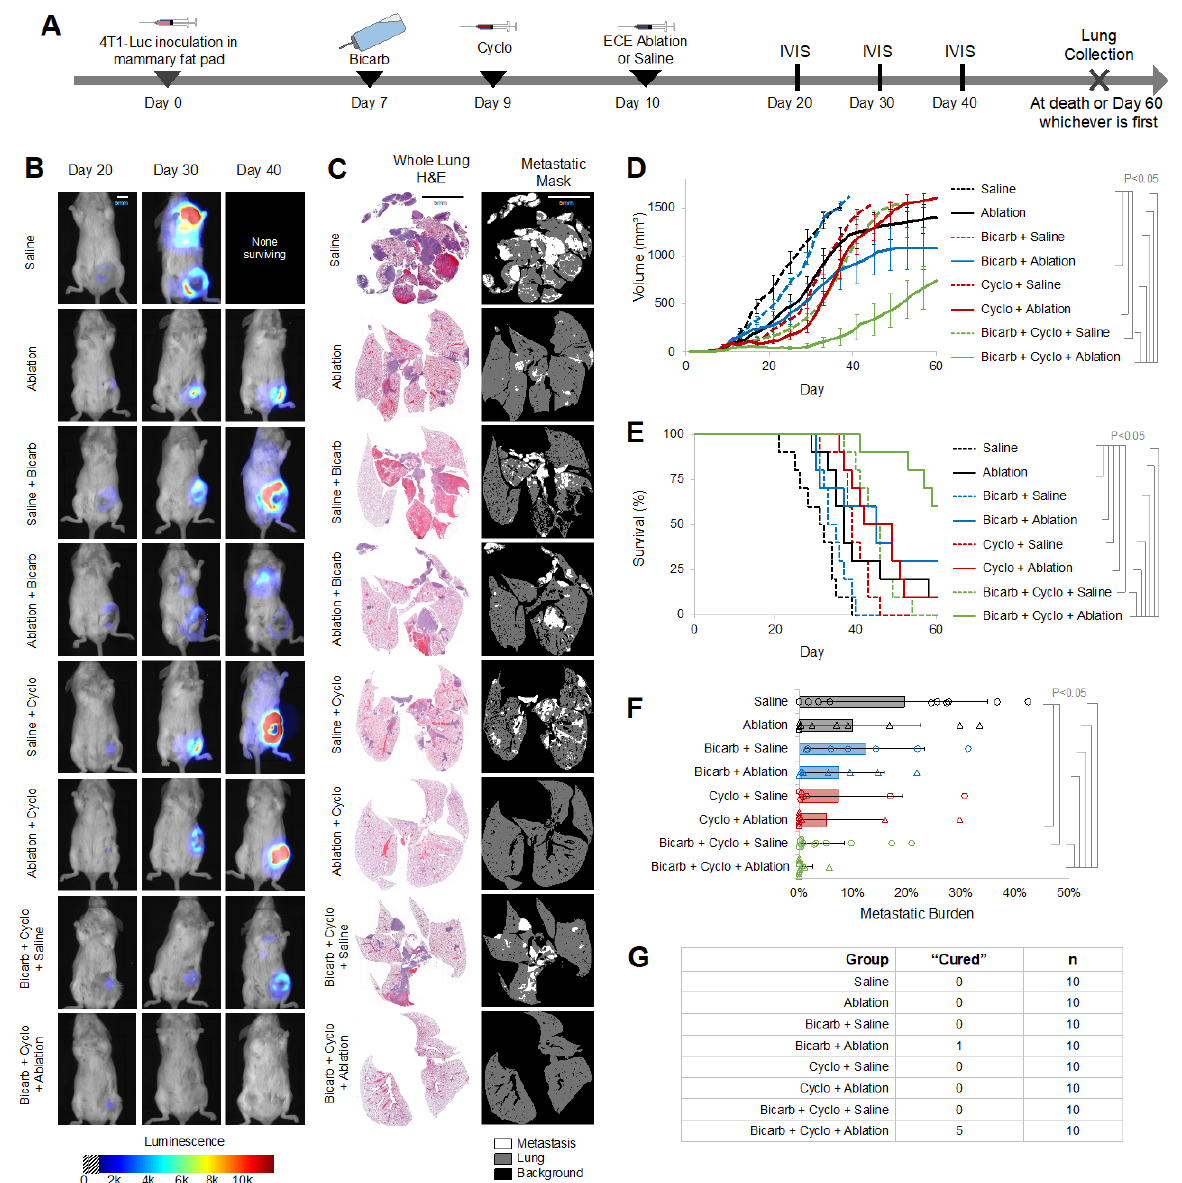
Figure 2. BiCyclA therapy reduced 4T1-luc tumor burden both locally and systemically. ( A ) Study timeline schematic for treatment of orthotopic 4T1-luc tumors. ( B ) Representative IVIS images from each treatment group with 4T1-luc tumors. ( C ) Representative whole-lung H&E and corresponding metastatic mask showing metastatic lesions in the lungs. ( D ) Average tumor volume over time. ( E ) Metastatic burden, or percent of lung area occupied by metastatic lesions, for each treatment group. Black bar represents average. ( F ) Survival rates for mice bearing 4T1-Luc tumors, n = 10. ( G ) Number of mice out of 10 per treatment group with no detectable metastases or primary tumor at day 60. Scale bar equals 5 mm in